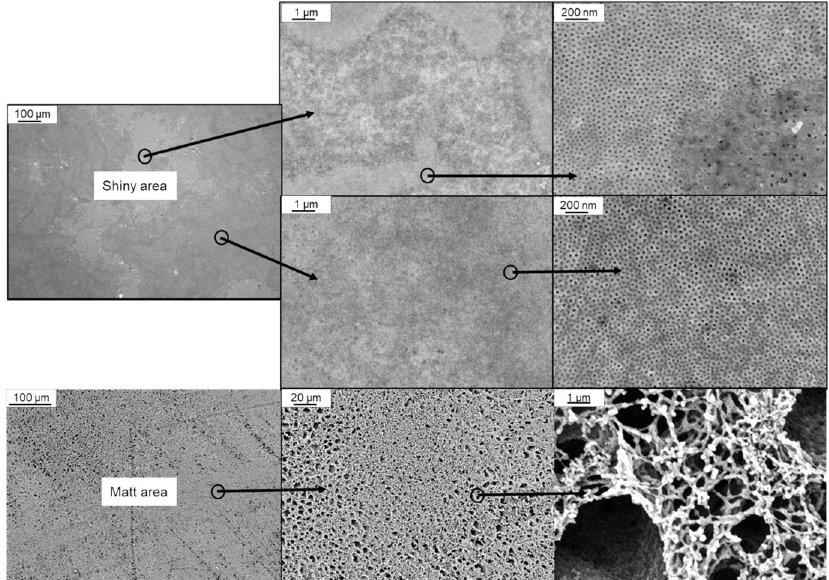
Figure 5. SEM images of BCP membranes sprayed on a supporting PAN-membrane with an airbrush system using 1 wt% of PS 83 - b -P4VP 1788 solution in 1,4-dioxane. Magnification of different parts of the main shiny area with partial typical pores of BCP membranes, and the matt area without hexagonally arranged pores are shown (bottom).